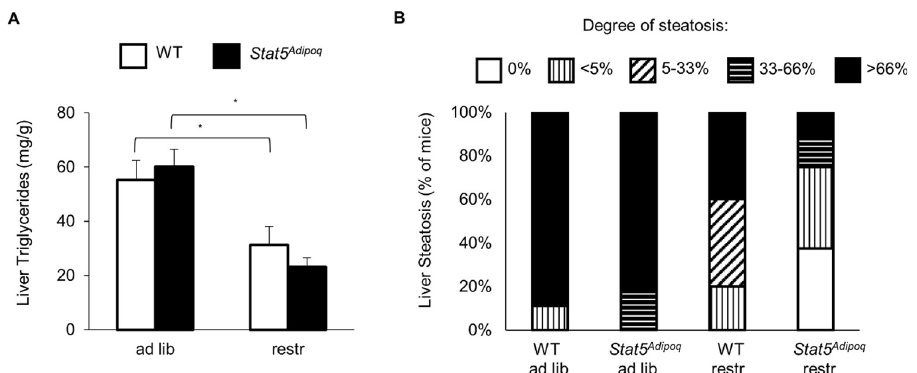
Fig 5. Effects of STAT5 adipocyte deficiency on liver histology. After 7.5 weeks of high fed diet (HFD), 23–24 week- old male mice lacking STAT5 in their adipocytes ( Stat5 Adipoq ) and their wild type controls (WT) were split into two groups, one fed HFD ad libitum (ad lib) and one fed restrictedly (1 g/d) (restr) for the following 4.5 weeks. Hepatic steatosis was determined by measuring triglyceride concentration in liver extracts (means ± SEM; � p < 0.05 ad lib vs restr; no significant differences for WT vs Stat5 Adipoq ; A), as well as by histological score (B). n = 7–12 per group.